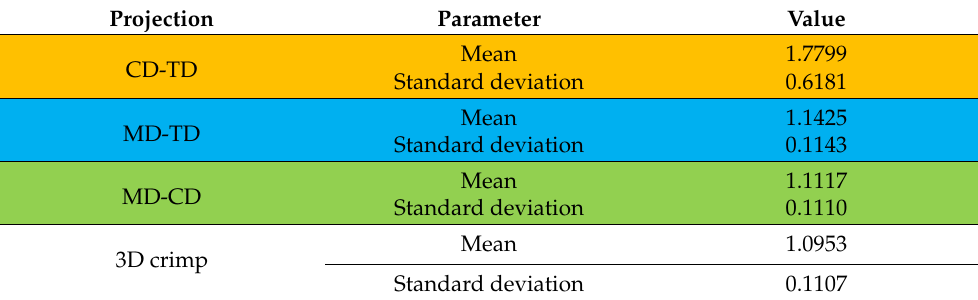
Table 3. Statistical data of small-size RFN.